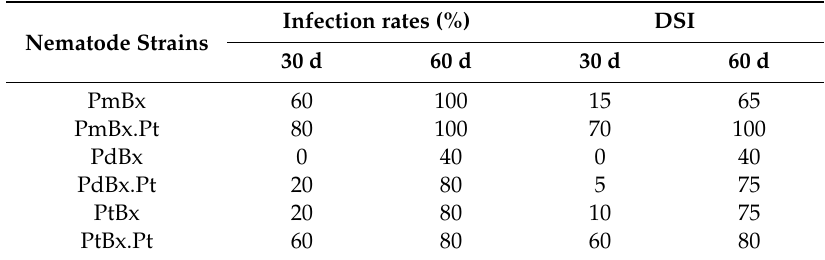
Figure 6. The symptoms of Pinus thunbergii after inoculation for 60 d with different Bursaphelenchus xylophilus isolates. Each treatment of this experiment has five saplings (The two small saplings in the second pot from the left in PmBx treatment and the leftmost pot in PmBx.Pt treatment was not treated. The two saplings in the leftmost pot in PtBx.Pt treatment was all treated.). Table 3. The symptoms at 30 d and 60 d of Pinus thunbergii inoculated with different Bursaphelenchus xylophilus isolates.